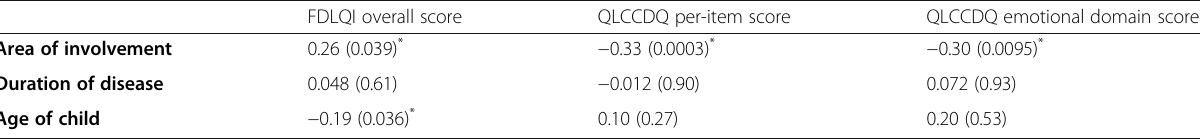
Table 3 Correlations (and p -value) between parent QoL measures and % of area involvement, duration of disease and age at diagnosis of child with